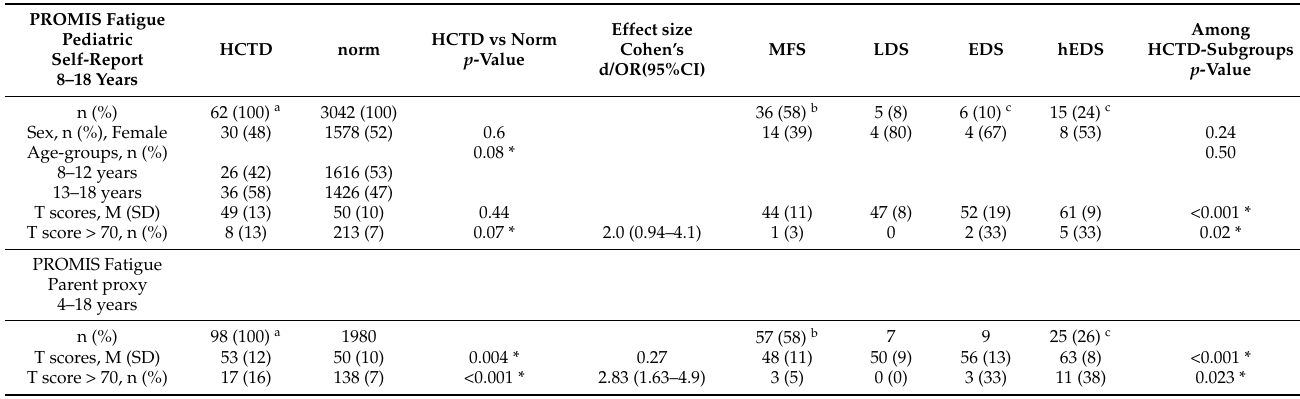
Table 2. The Patient Reported Outcomes Measurement Information System (PROMIS) Fatigue 10a–Pediatric v2.0 Short form and the PROMIS Fatigue 10a–Parent Proxy v2.0 Short form: T-scores of normative data, the HCTD-group and the HCTD-subgroups: MFS, LDS, EDS and hEDS; comparisons between normative T-scores and HCTD-group T-scores; and comparisons among HCTD-subgroup T-scores.